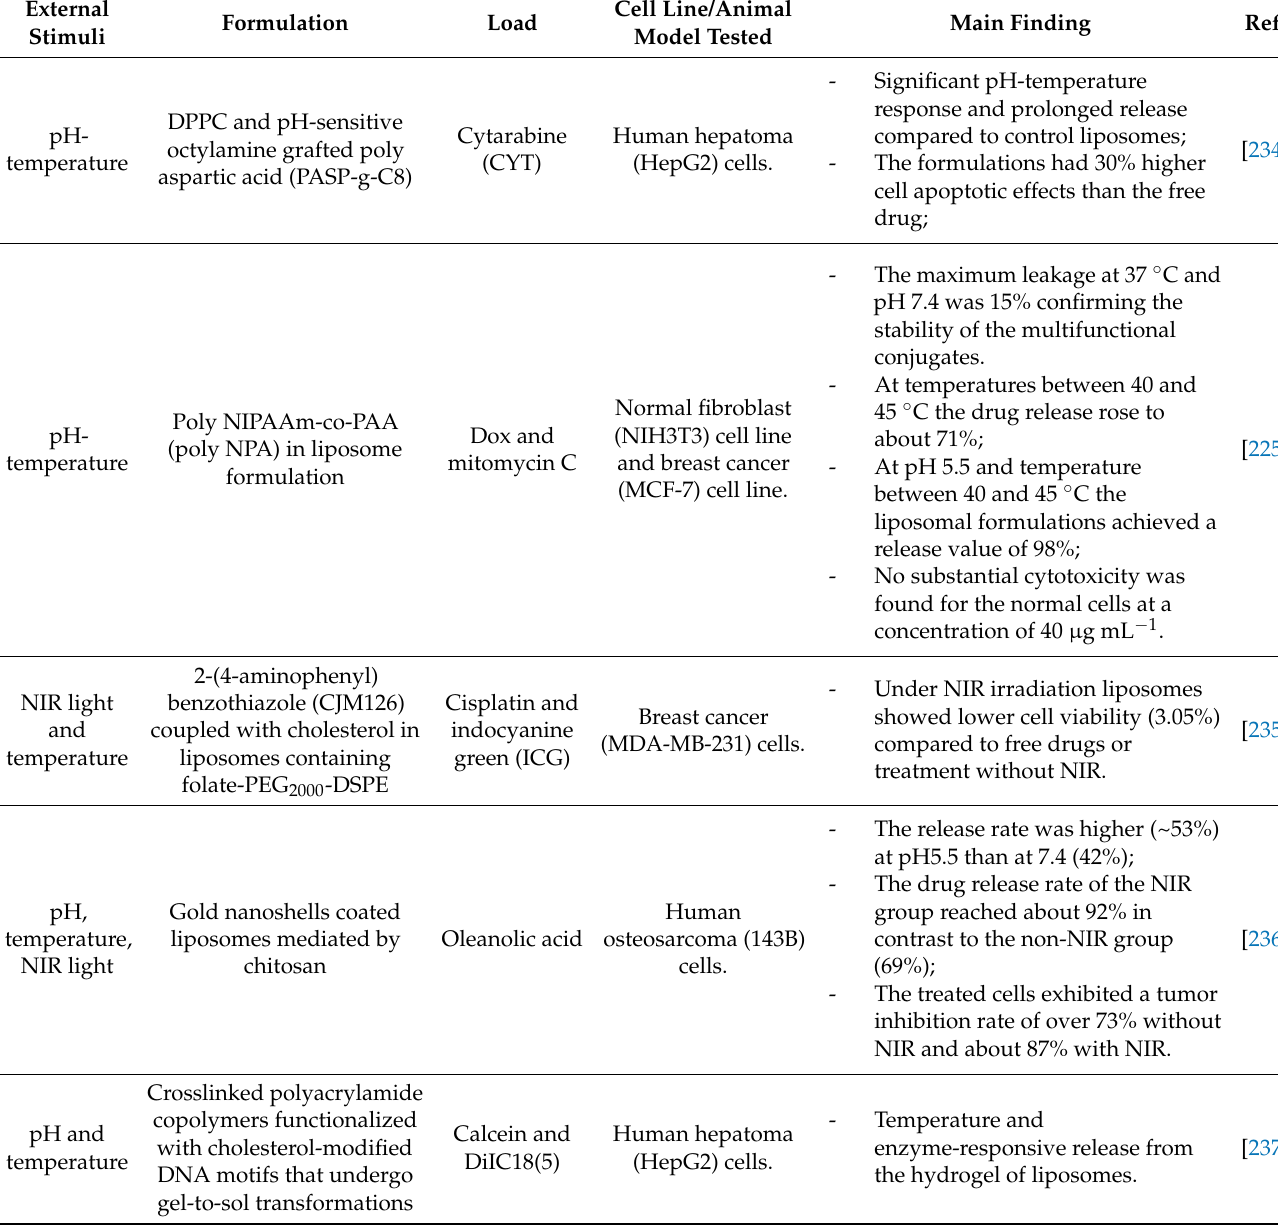
Table 5. Recent studies focusing on dual-sensitive liposomal